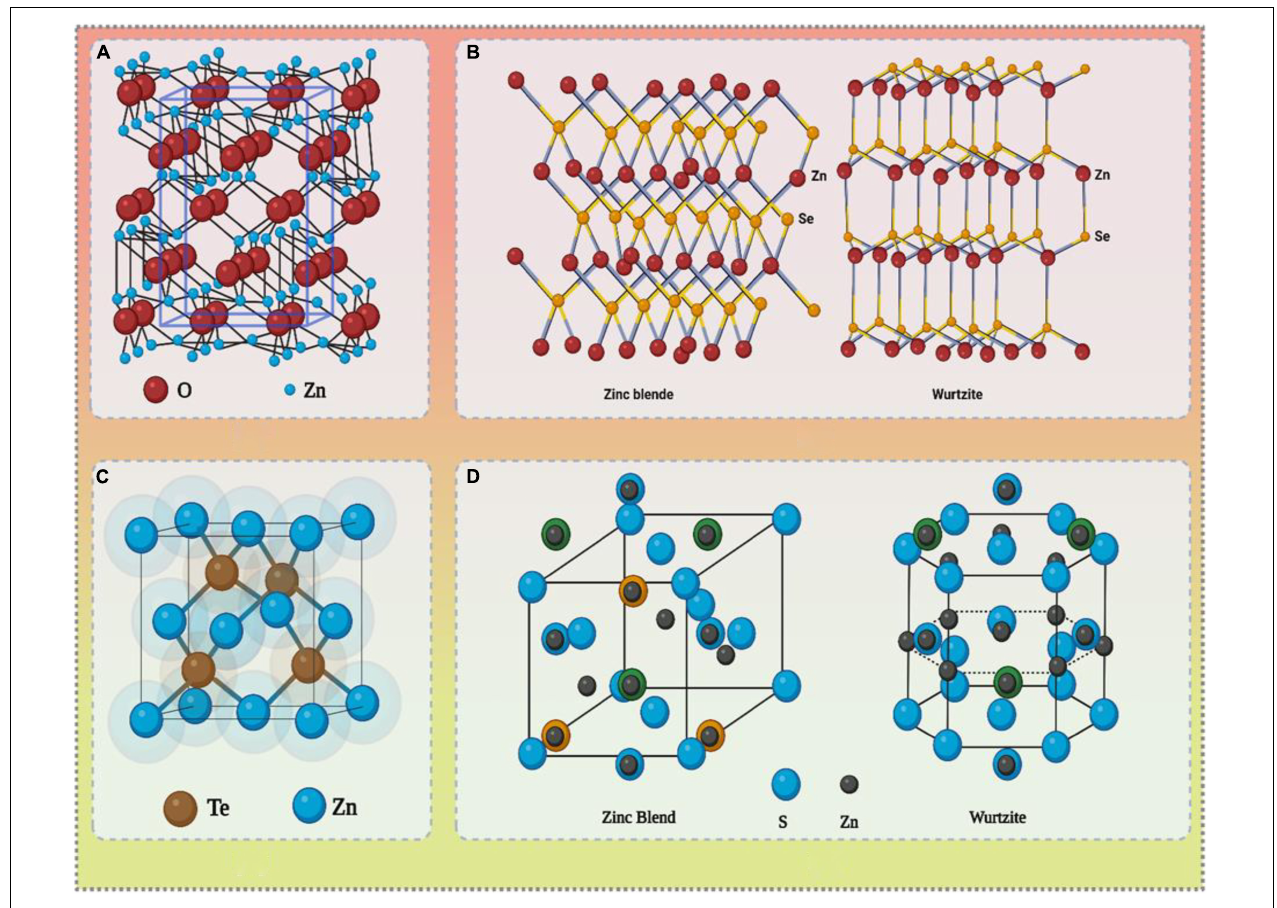
FIGURE 1 | Crystal structure of various ZnNPs: (A) ZnO, (B) ZnSe, (C) ZnTe, and (D)